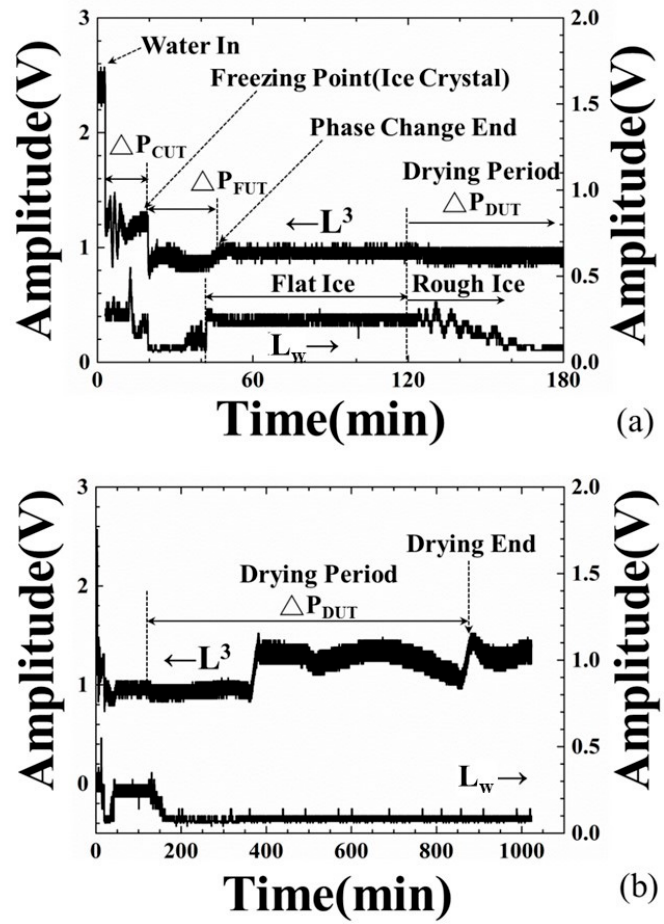
Figure 6. Amplitude variations of ultrasonic L 3 and L w echoes during freeze-drying process at ( a ) freezing stage and ( b ) drying stage, indicating the water-in, freezing point (ice crystal), phase change end and drying end.